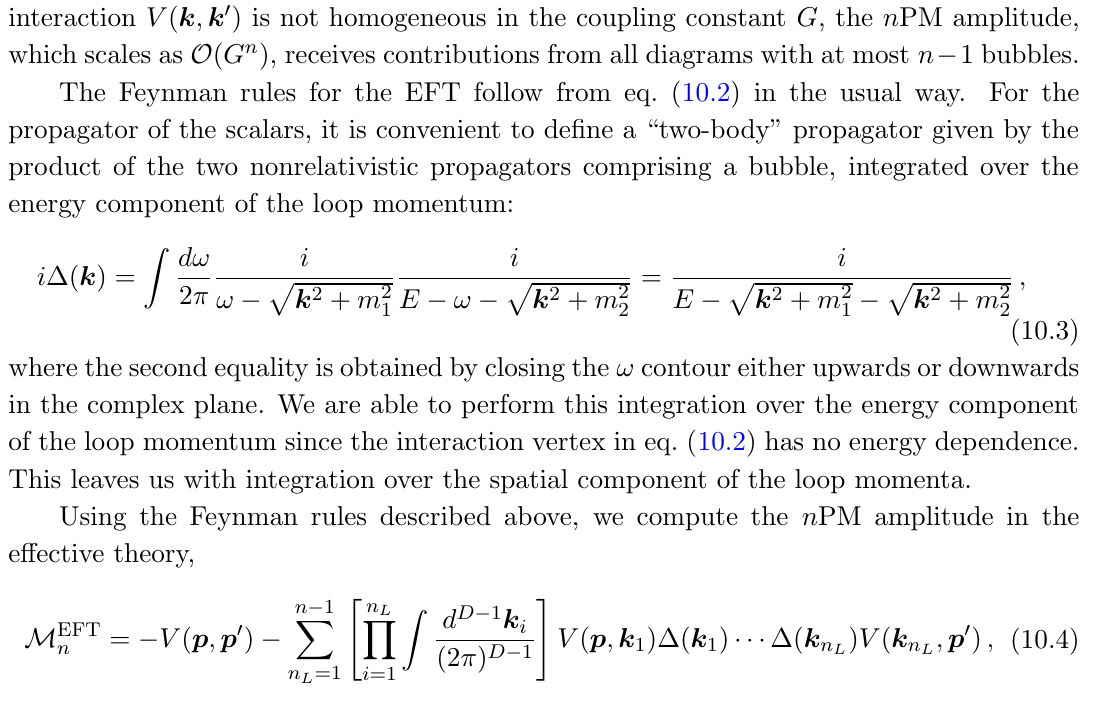
The EFT amplitude is given by the sum of iterated bubbles shown in (cid:12)gure 29. Note that particle number is conserved in such diagrams; topologies involving pair production of the massive states is kinematically forbidden in the classical nonrelativistic limit. Since the interaction V ( k ; k 0 ) is not homogeneous in the coupling constant G , the n PM